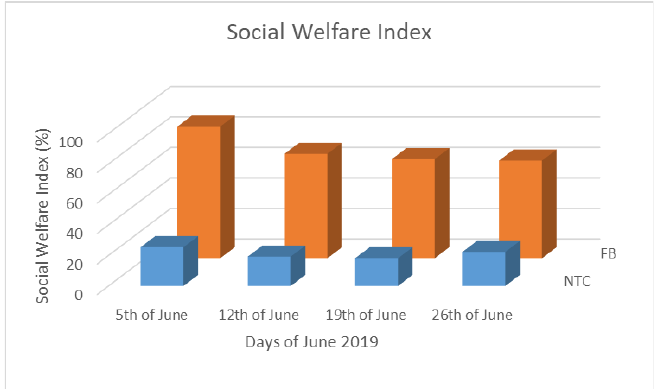
Figure 4. Social welfare index for the five-country scenario via both approaches. Electricity 2022 , 3 , FOR PEER REVIEW